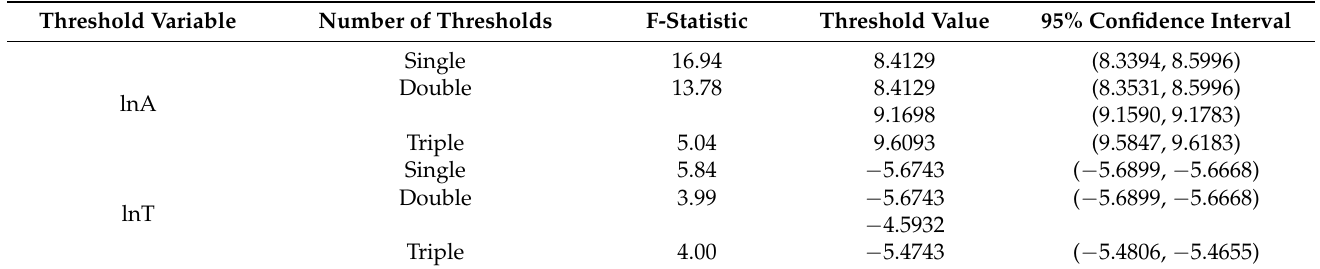
Table 4. Tests for threshold effect and threshold value estimation of the western